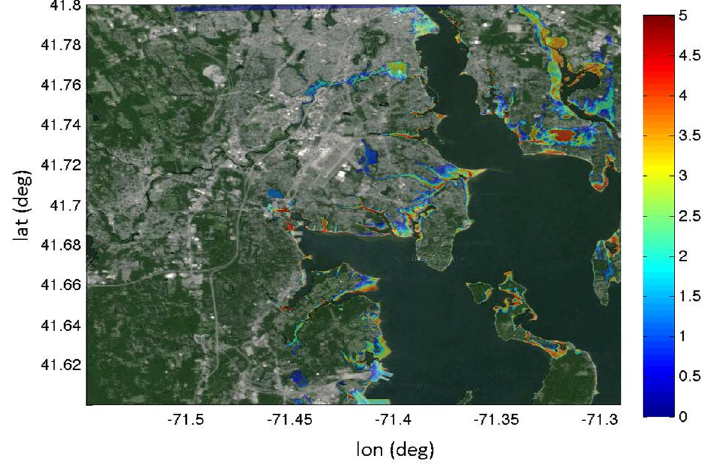
Figure 13. Inundation depths (m) relative to grade for Warwick, RI for 100 year event.